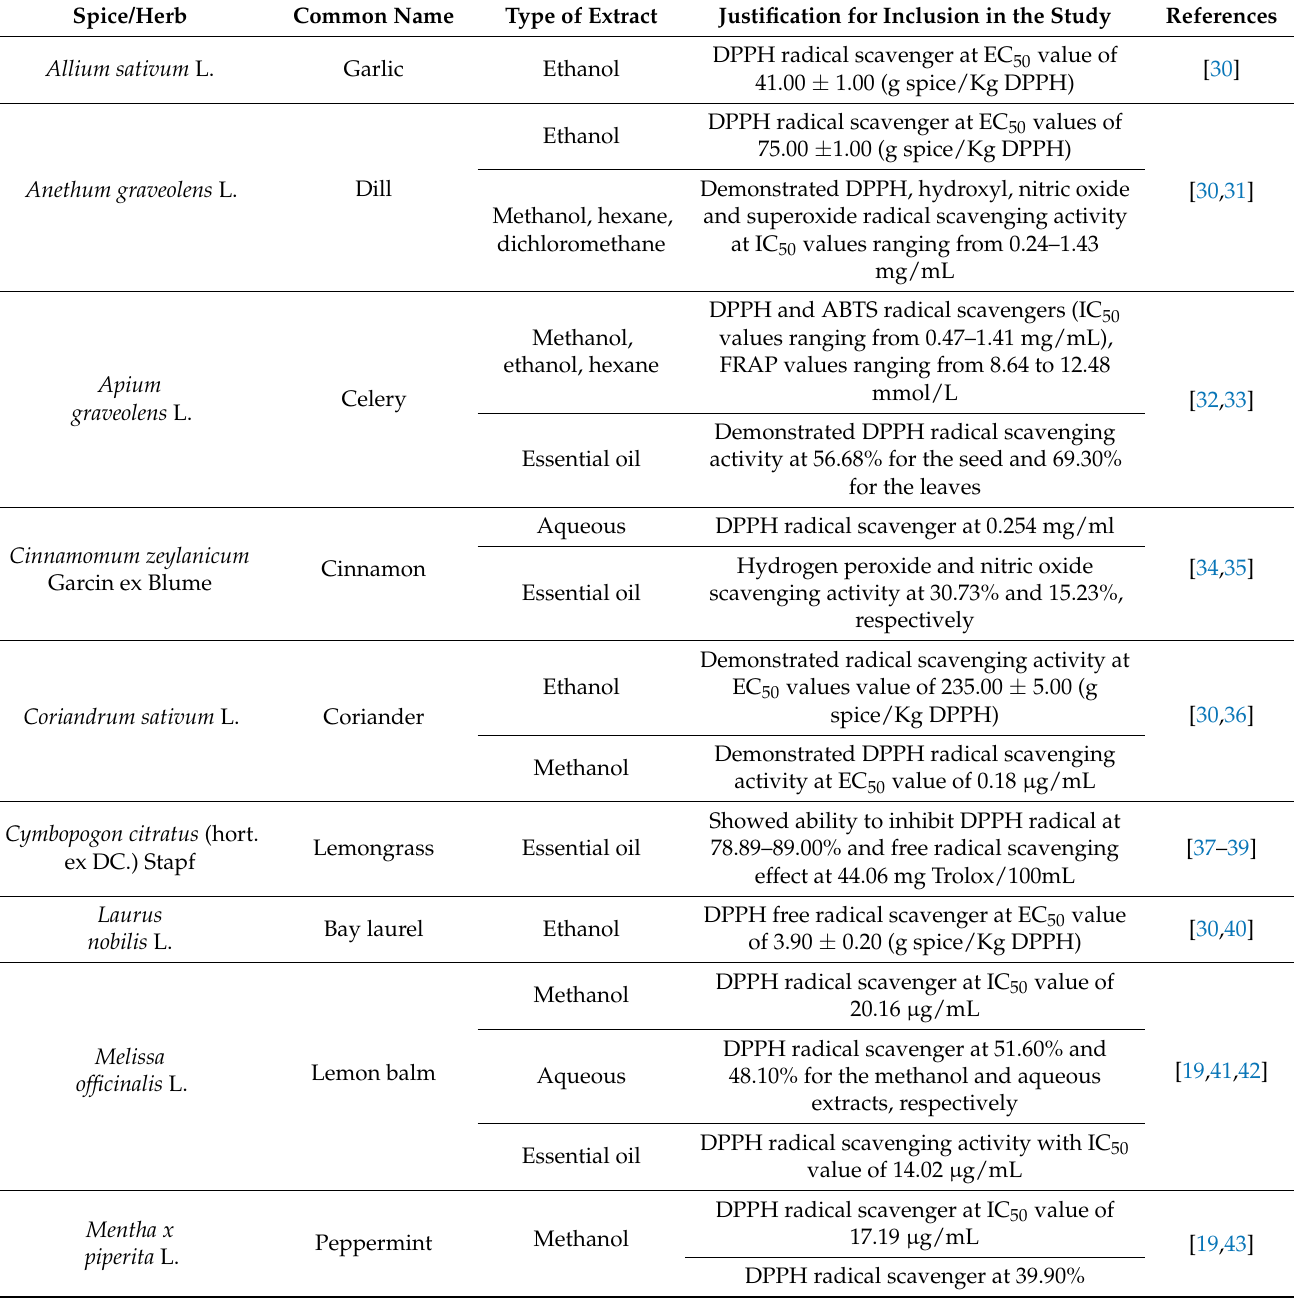
Table 6. Common culinary herbs and spices with documented antioxidant